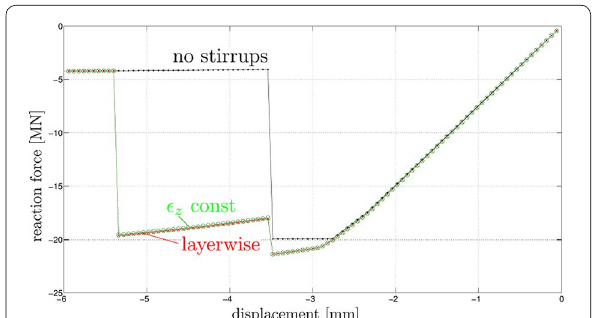
Fig. 7 Axial stress distribution in concrete at peak load for constant ǫ c u = 0.0053 , a without stirrups and b considering stirrups, with axial reinforcements shown in black.